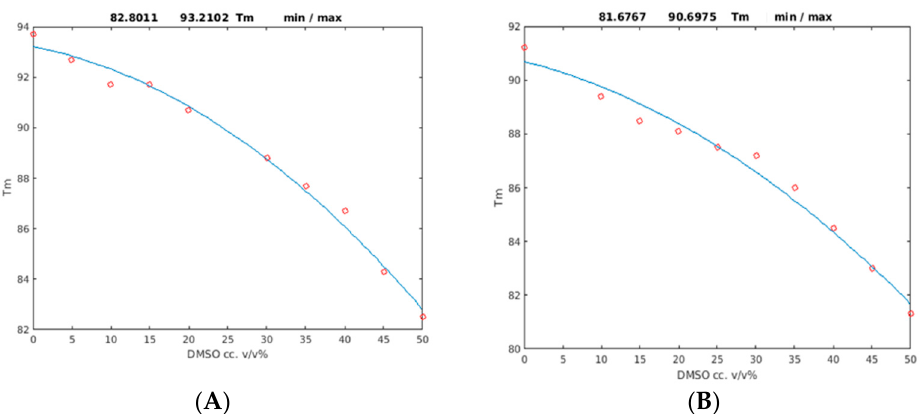
Figure 5. Thermodynamic stability of PAF ( A ) and PAF D19S ( B ) as a function of the DMSO concen- tration. Second ‐ order polynomials fitted to the melting point temperatures ( T m ) are shown in both cases. T m values are shown in °C on the vertical scale. Table 1. The parabolic fitting of melting points as T m (x) = p 1 *x 2 + p 2 *x + p 3 parameters of the DSC experimental data for PAF and PAF D19S . The melting points are given as the values from the fits. Protein p 1 (* 10 − 3